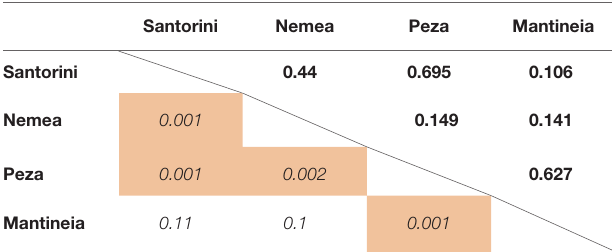
TABLE 2 | ANOSIM pairwise tests for differences on yeast community composition between